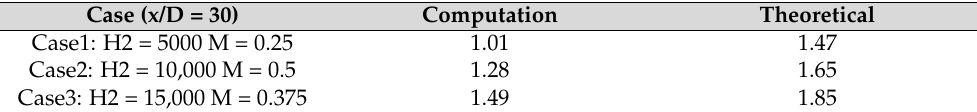
Table 2. Computational and theoretical data of ∆ T 1 / ∆ T 2 under different conditions.